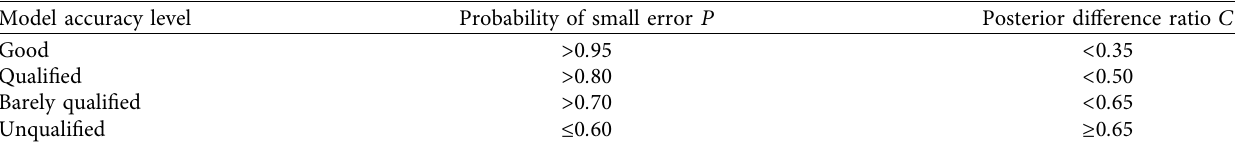
Table 2: Classification standard of precision grade of grain yield prediction model.